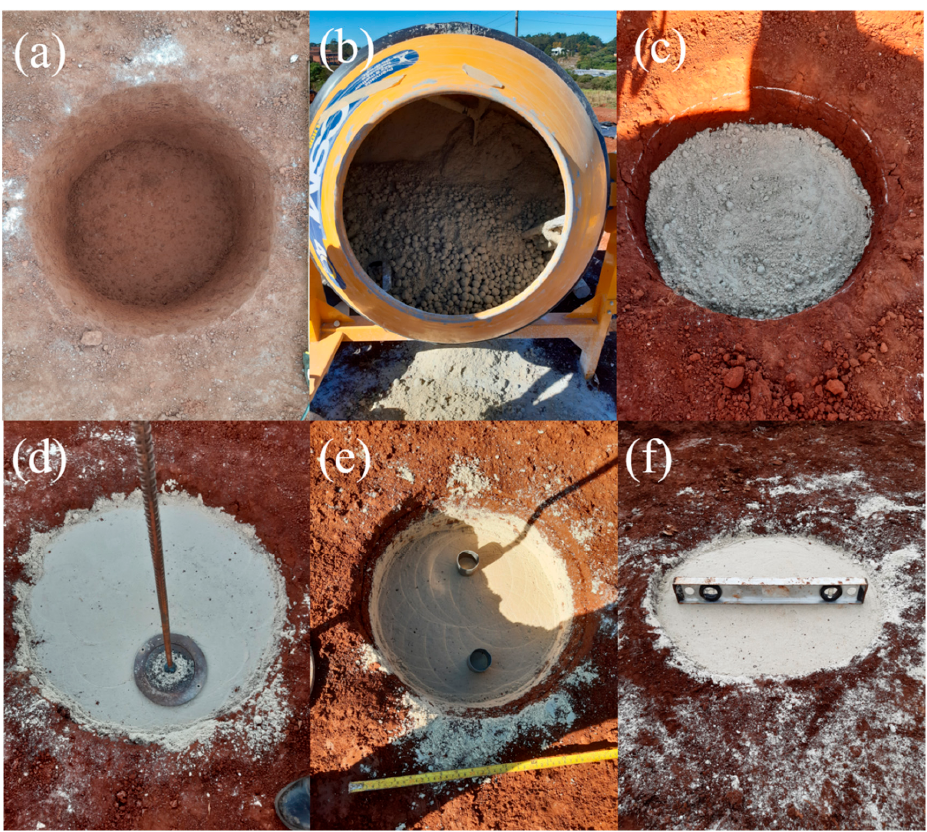
Figure 3. Field molding process ( a ) pit opening; ( b ) mixing preparation; ( c ) mixture placed in the pit; ( d ) compaction of the mixture; ( e ) sampling to control specific weight and humidity; ( f ) final stabilized layer. Table 4. Values of dry unit weight and moisture content for each experimental layer, determined during the molding process .